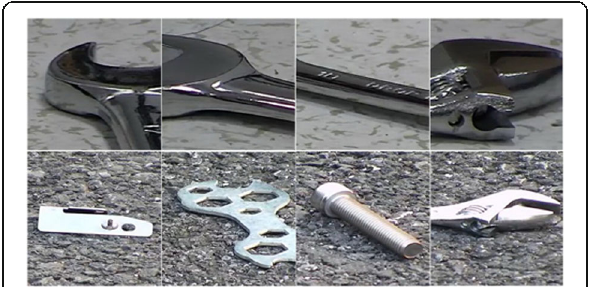
Fig. 7 Samples from the FOD verification dataset